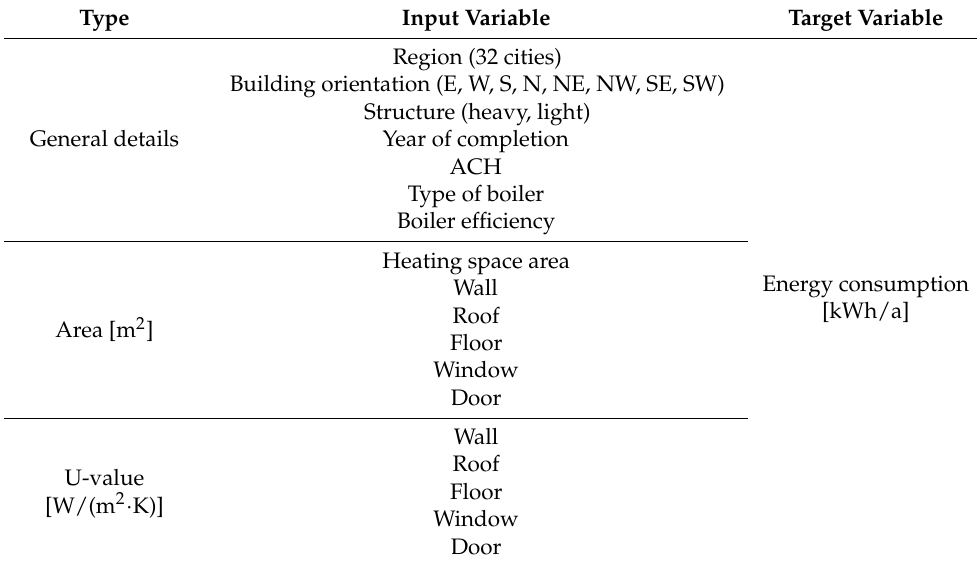
Table 2. Input variables and target variables considered for the DNN modelling of old houses.